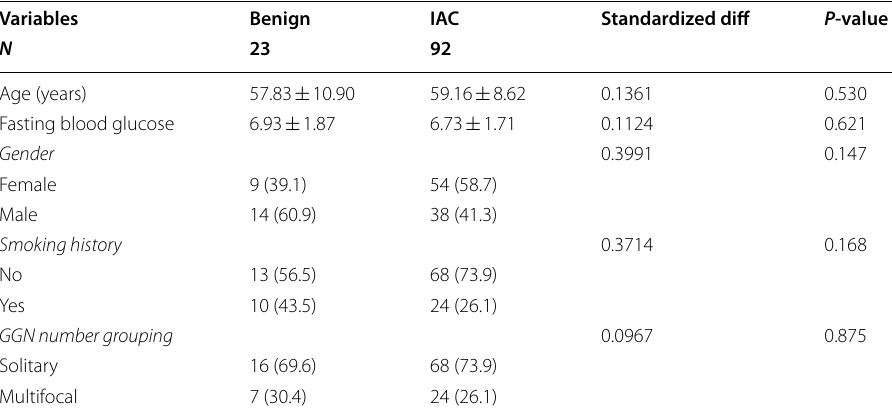
The results in the table are expressed as Mean GGN, ground‑glass nodule; PSM, propensity score matching; IAC, invasive